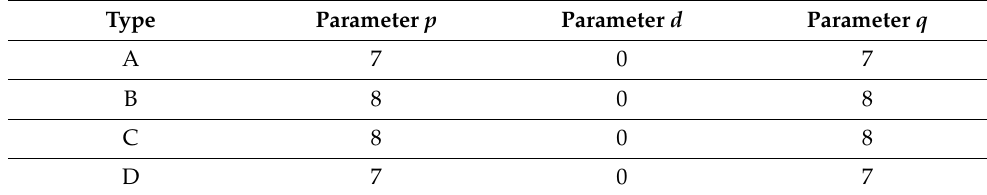
Figure 6. ACF results for each type. Table 2. Parameters of the optimal ARIMA model for each type.